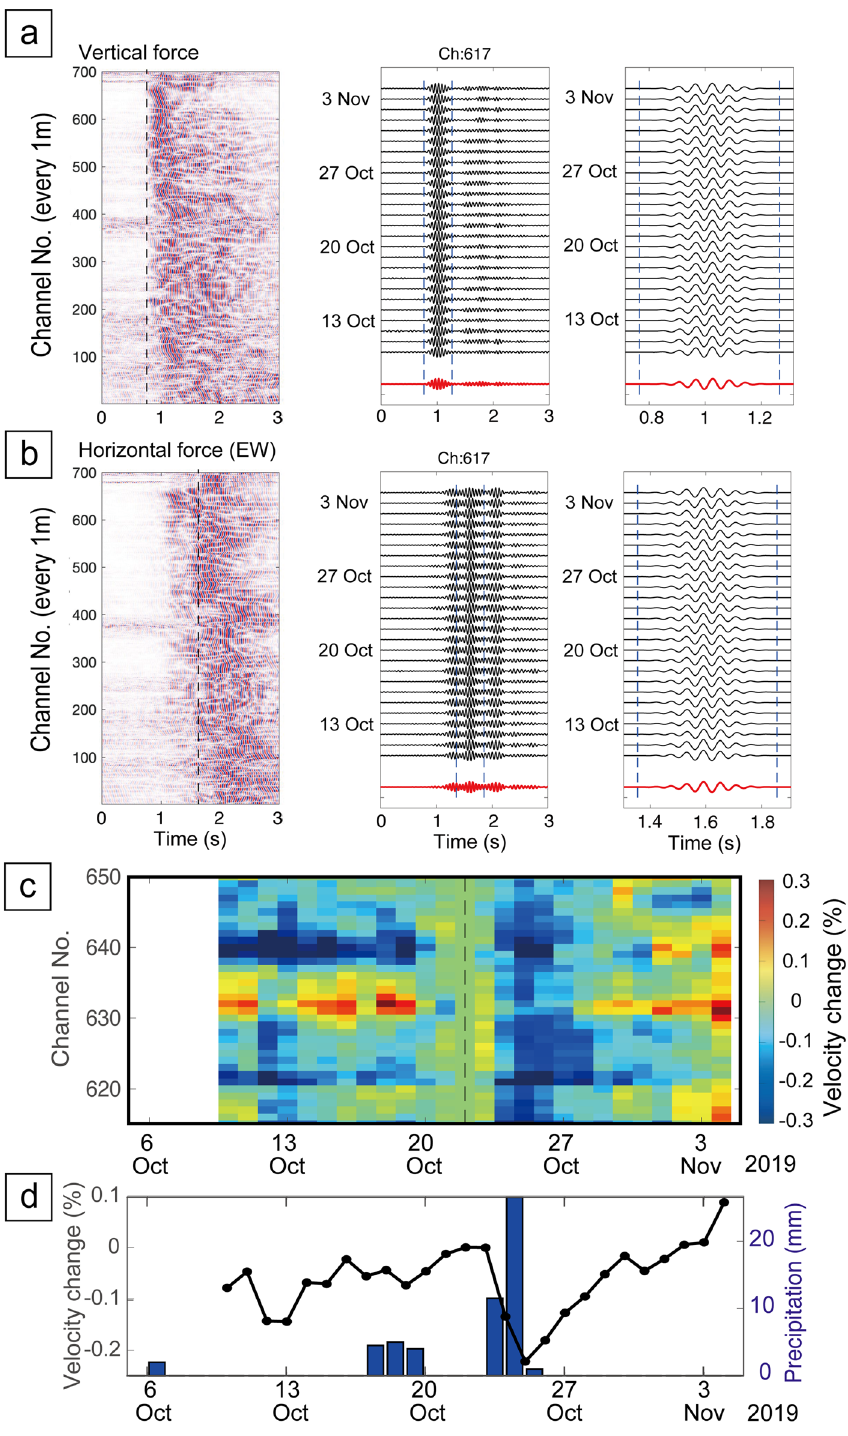
Figure 9. Monitoring results derived from the DAS system ~ 1.75 km from the source system. ( a ) Transfer functions at all receiver channels derived from vertical source motion (left) and temporal variation of channel 617 (middle and right). ( b ) Transfer functions at all receiver channels derived from horizontal source motion and temporal variation of channel 617. ( c ) Temporal variation of P-wave velocity for channels #615–#650 from 10 October to 4 November. The velocity change is defined by using the velocity on 22 October as zero. ( d ) The velocity change averaged from channel #615–#650 results (black), and the precipitation from rain events